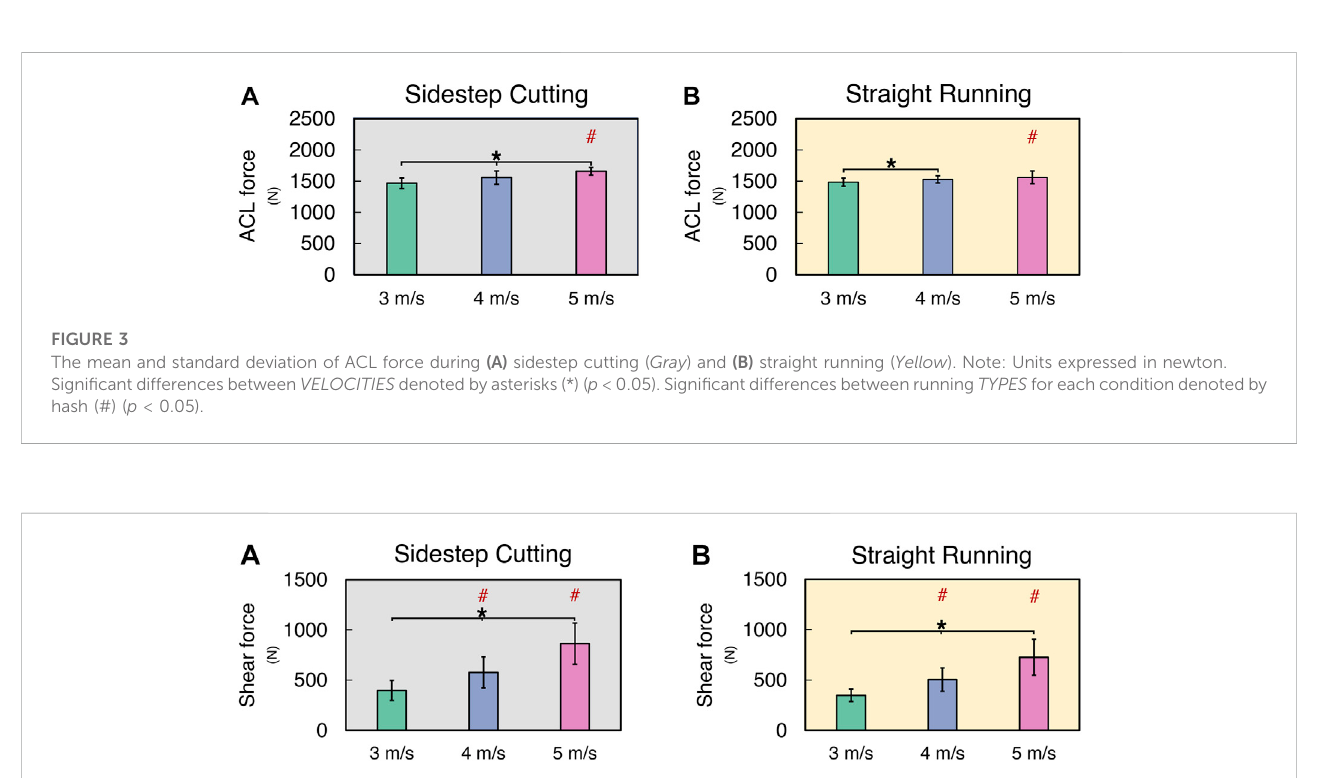
FIGURE 4 Themeanandstandarddeviationofkneeshearforceduring (A) sidestepcutting( Gray )and (B) straightrunning( Yellow ).Note:Unitsexpressedinnewton. Signi fi cant differences between VELOCITIES denoted byasterisks(*) ( p < 0.05). Signi fi cant differences betweenrunning TYPES for each condition denotedby hash (#) ( p <